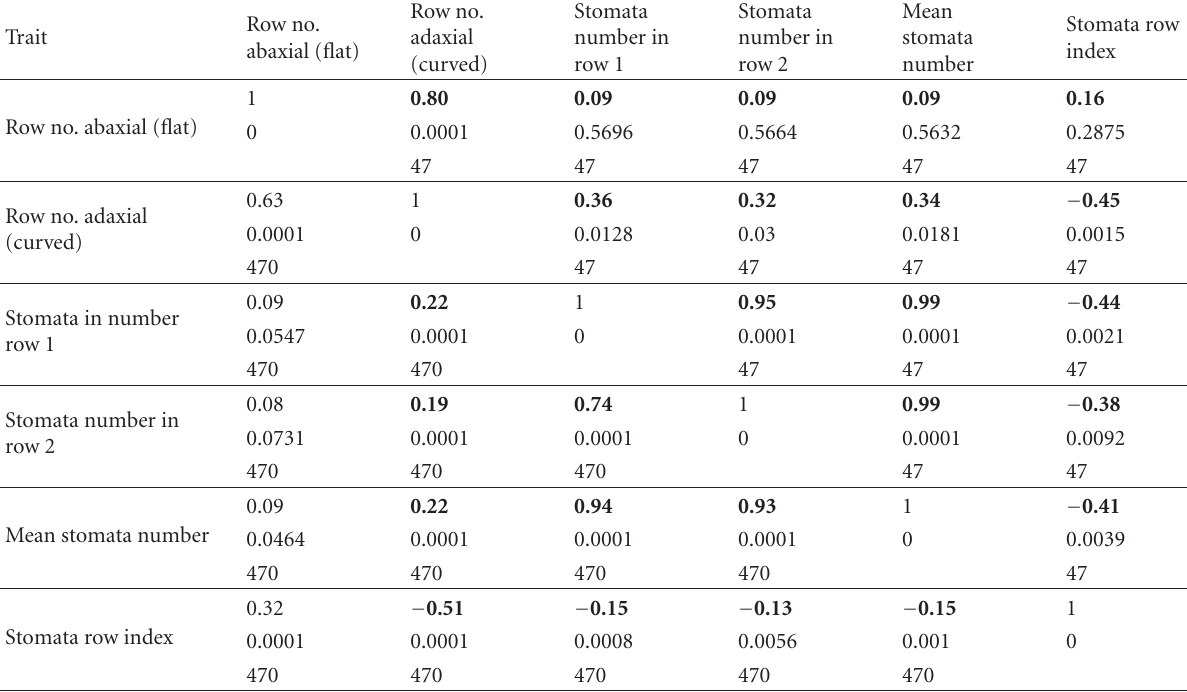
Table 6: Pearsons product-moment correlation coe ffi cients among the needle traits calculated on the tree mean level (upper diagonal) and the individual needle level (lower diagonal). The significance level and number of observations are given below the coe ffi cients. Row Trait